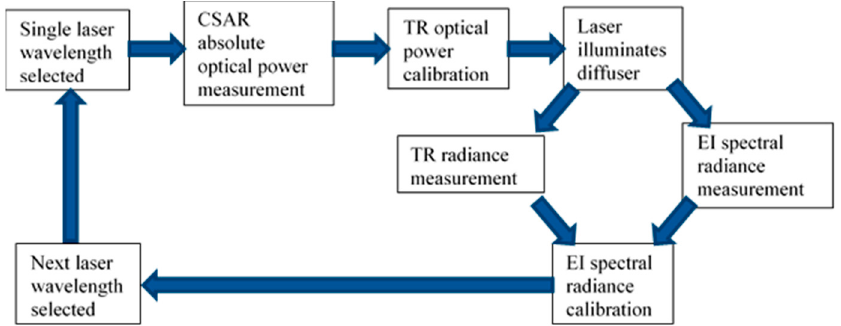
Figure 14. Schematic showing overall calibration sequence.